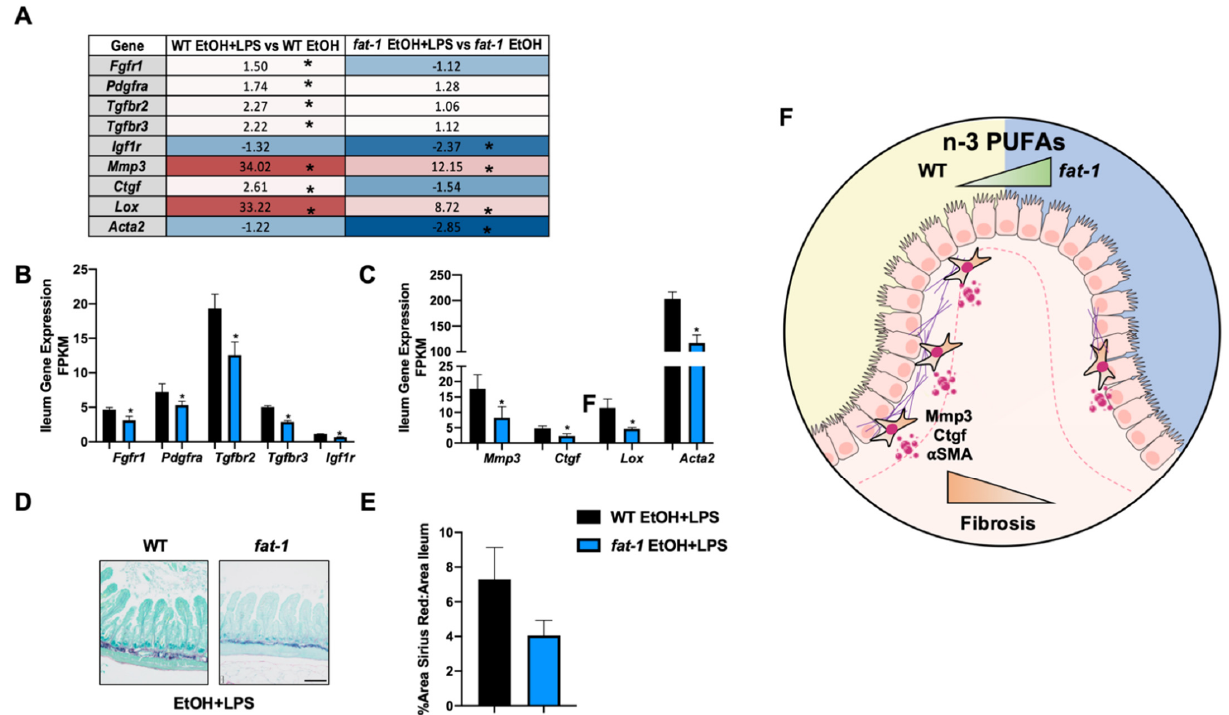
Figure 8. Increased n-3 PUFAs attenuated the EtOH + LPS mediated intestinal fibrosis. ( A ) Heatmap fold-change values for pro-fibrotic receptors and markers for the WT EtOH + LPS vs. WT EtOH comparison and the fat-1 EtOH + LPS vs. fat-1 EtOH comparison. ( B ) Gene expression of pro-fibrotic receptors in WT EtOH + LPS and fat-1 EtOH + LPS-treated mice. ( C ) Gene expression of pro-fibrotic markers in WT EtOH + LPS and fat-1 EtOH + LPS-treated mice. ( D ) Representative Images of Sirius red-stained ileal sections at 200× from WT EtOH + LPS and fat-1 EtOH + LPS-treated (scale bar is 40 μ m). ( E ) Quantification of Sirius red staining area relative to total ileum area for WT EtOH + LPS vs. fat-1 EtOH + LPS mice. ( F ) Graphical representation of diminished intestinal fibrosis associated with enhanced n-3 PUFAs. Statistical significance ( p < 0.05) is denoted by an *.